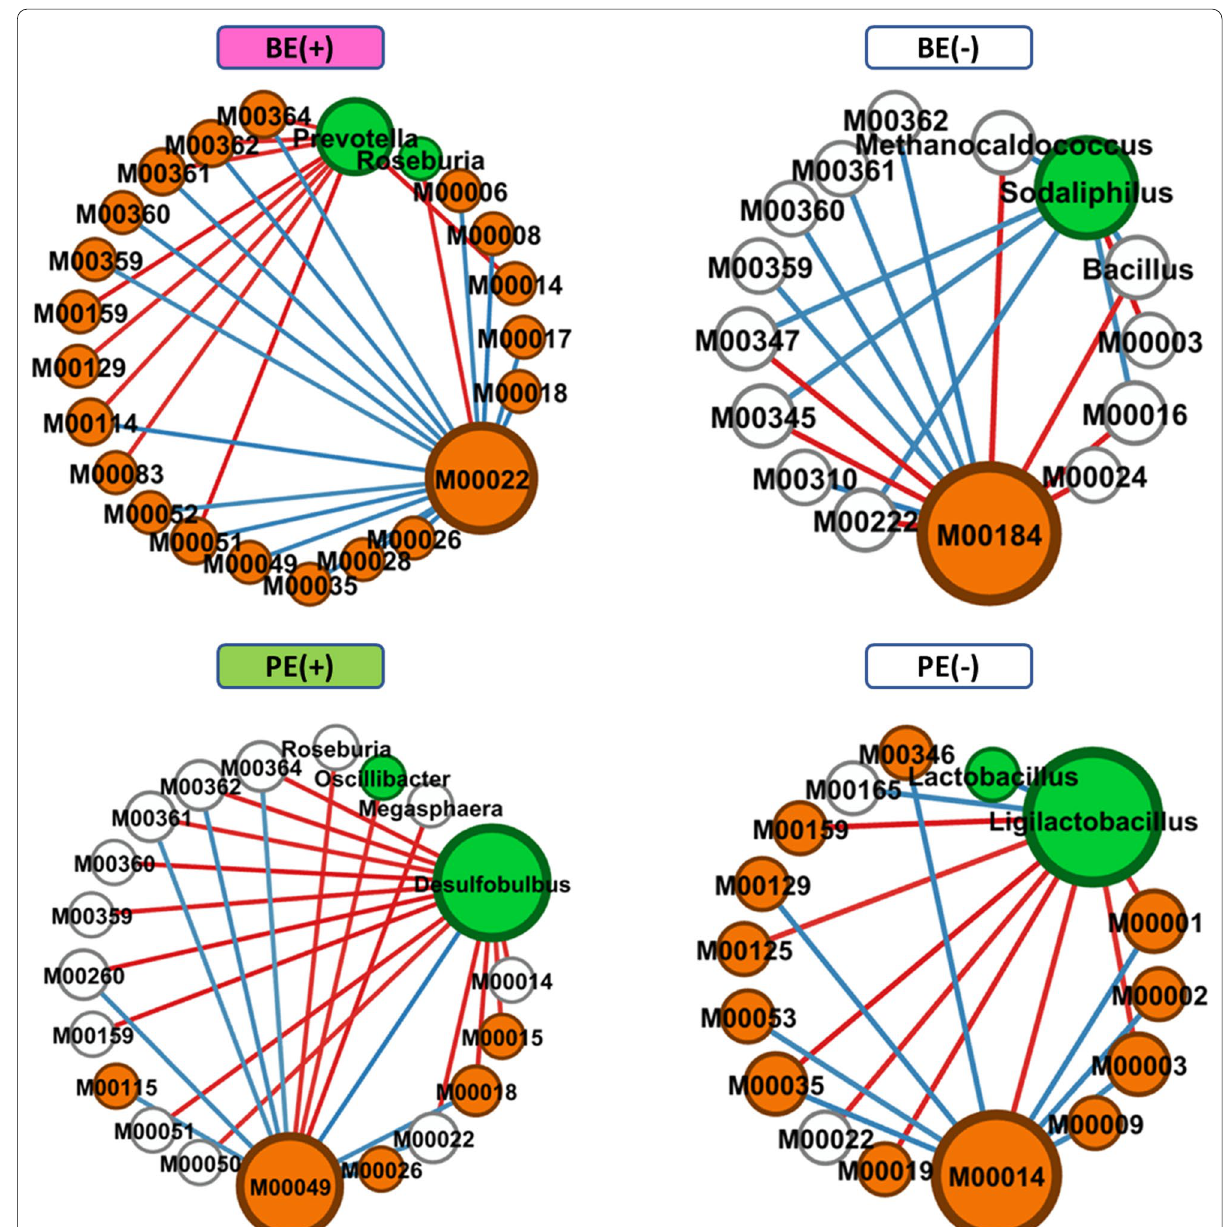
Fig. 6 Circular type networks interacted with keystone nodes (either microbial or functional) at each microbial inoculation treatment. Exclusive node was denoted by blue for archaeal, green for bacterial and orange for the functional features. Edge color represents co-occurrence (blue) or mutual exclusive (red) interactions. Edge thickness was adjusted based on the absolute value of the correlation coefficients of each interaction. BE, bacterial-enriched rumen fluid; PE, protozoal-enriched rumen